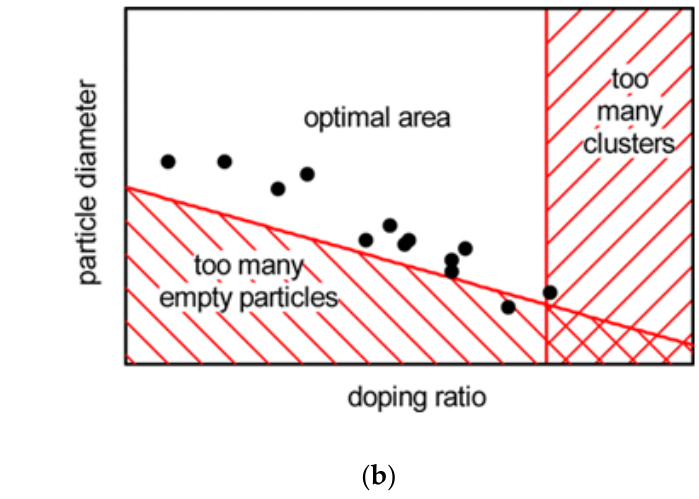
Figure 1. ( a ) Illustration of basic postulates of the electronic theory of catalysis. ( b ) Illustration of the statistical approach for the optimal doping concentration, adapted with permission from [14]. Copyright 2012 American Chemical Society.